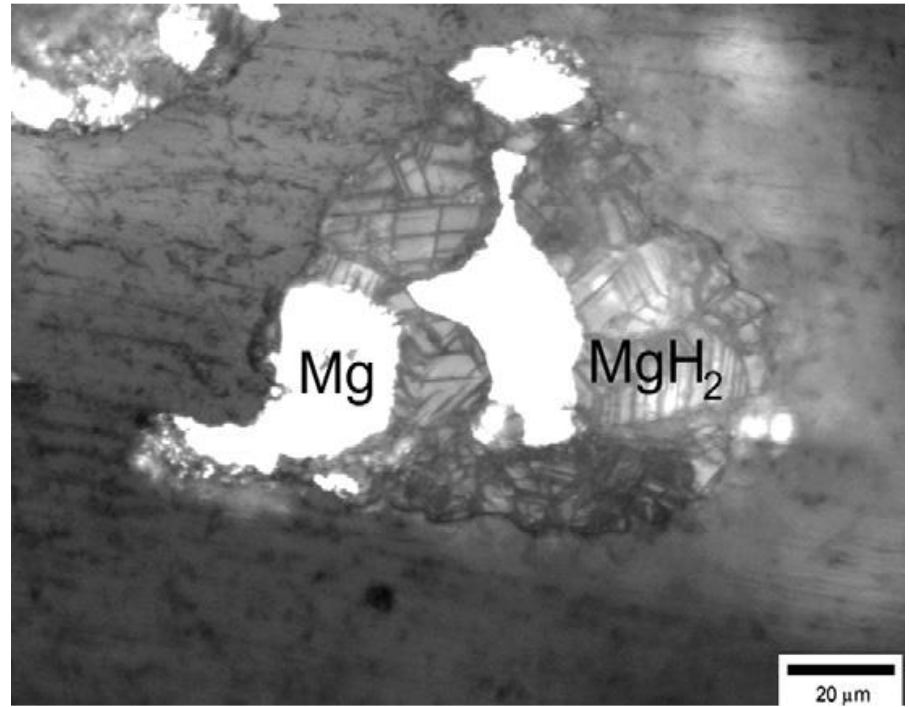
Figure 2. Optical microscopy photograph of the etched metallographic section of a partially decom- posed magnesium hydride (approximate bulk composition of the sample MgH 1.3 ) [57].